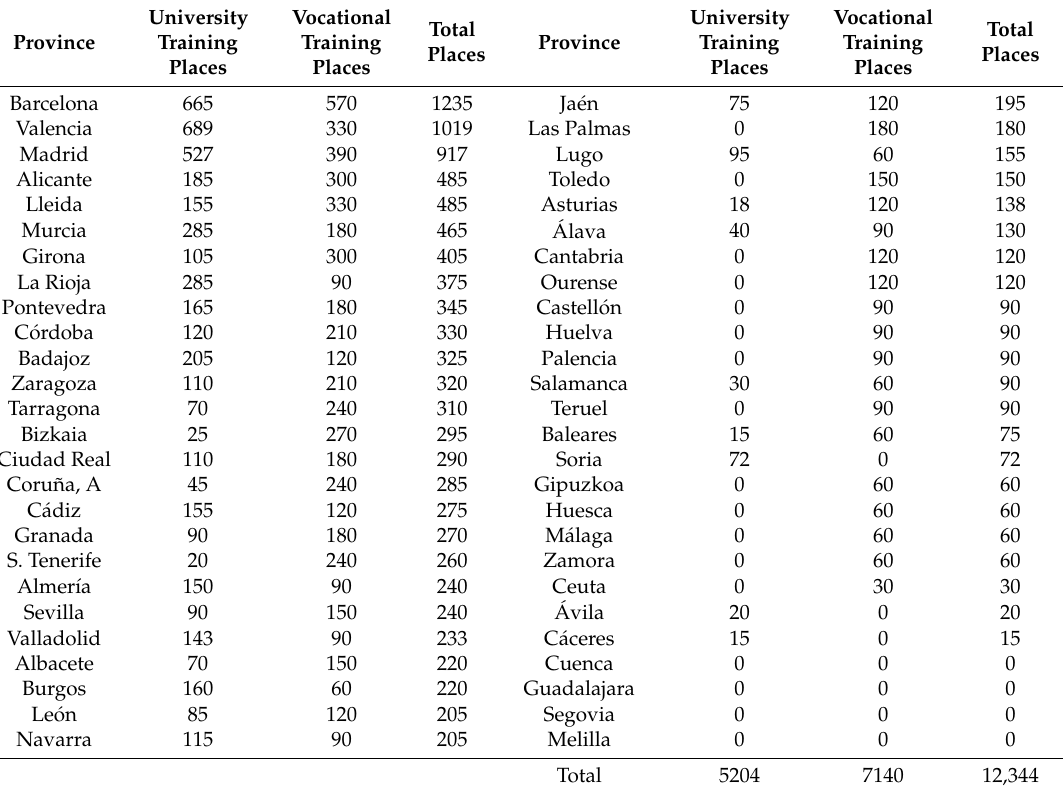
Table 4. Training offer in the food industry context by provinces,